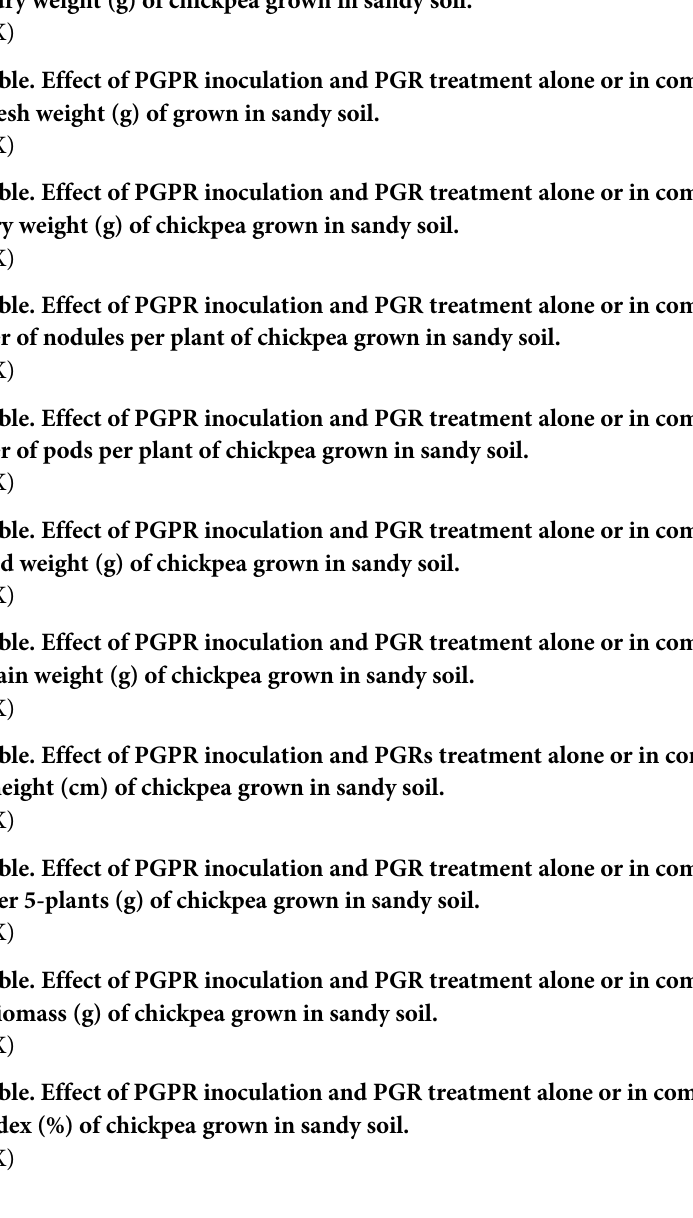
S11 Table. Effect of PGPR inoculation and PGR treatment alone or in combination on superoxide dismutase activity (units/g fwt.) in the leaves of chickpea grown in sandy soil. (DOCX) S12 Table. Effect of PGPR inoculation and PGR treatment alone or in combination on rel- ative water content (%) of chickpea grown in sandy soil. (DOCX) S13 Table. Effect of PGPR inoculation and PGR treatment alone or in combination on shoot fresh weight (g) of chickpea grown in sandy soil. (DOCX) S14 Table. Effect of PGPR inoculation and PGR treatment alone or in combination on shoot dry weight (g) of chickpea grown in sandy soil. S15 Table. Effect of PGPR inoculation and PGR treatment alone or in combination on root fresh weight (g) of grown in sandy soil. S16 Table. Effect of PGPR inoculation and PGR treatment alone or in combination on root dry weight (g) of chickpea grown in sandy soil. S17 Table. Effect of PGPR inoculation and PGR treatment alone or in combination on number of nodules per plant of chickpea grown in sandy soil. S18 Table. Effect of PGPR inoculation and PGR treatment alone or in combination on number of pods per plant of chickpea grown in sandy soil. (DOCX) S19 Table. Effect of PGPR inoculation and PGR treatment alone or in combination on 100-pod weight (g) of chickpea grown in sandy soil. (DOCX) S20 Table. Effect of PGPR inoculation and PGR treatment alone or in combination on 100-grain weight (g) of chickpea grown in sandy soil. (DOCX) S21 Table. Effect of PGPR inoculation and PGRs treatment alone or in combination on plant height (cm) of chickpea grown in sandy soil. (DOCX) S22 Table. Effect of PGPR inoculation and PGR treatment alone or in combination on yield per 5-plants (g) of chickpea grown in sandy soil. (DOCX) S23 Table. Effect of PGPR inoculation and PGR treatment alone or in combination on total biomass (g) of chickpea grown in sandy soil. (DOCX) S24 Table. Effect of PGPR inoculation and PGR treatment alone or in combination on har- vest index (%) of chickpea grown in sandy soil.